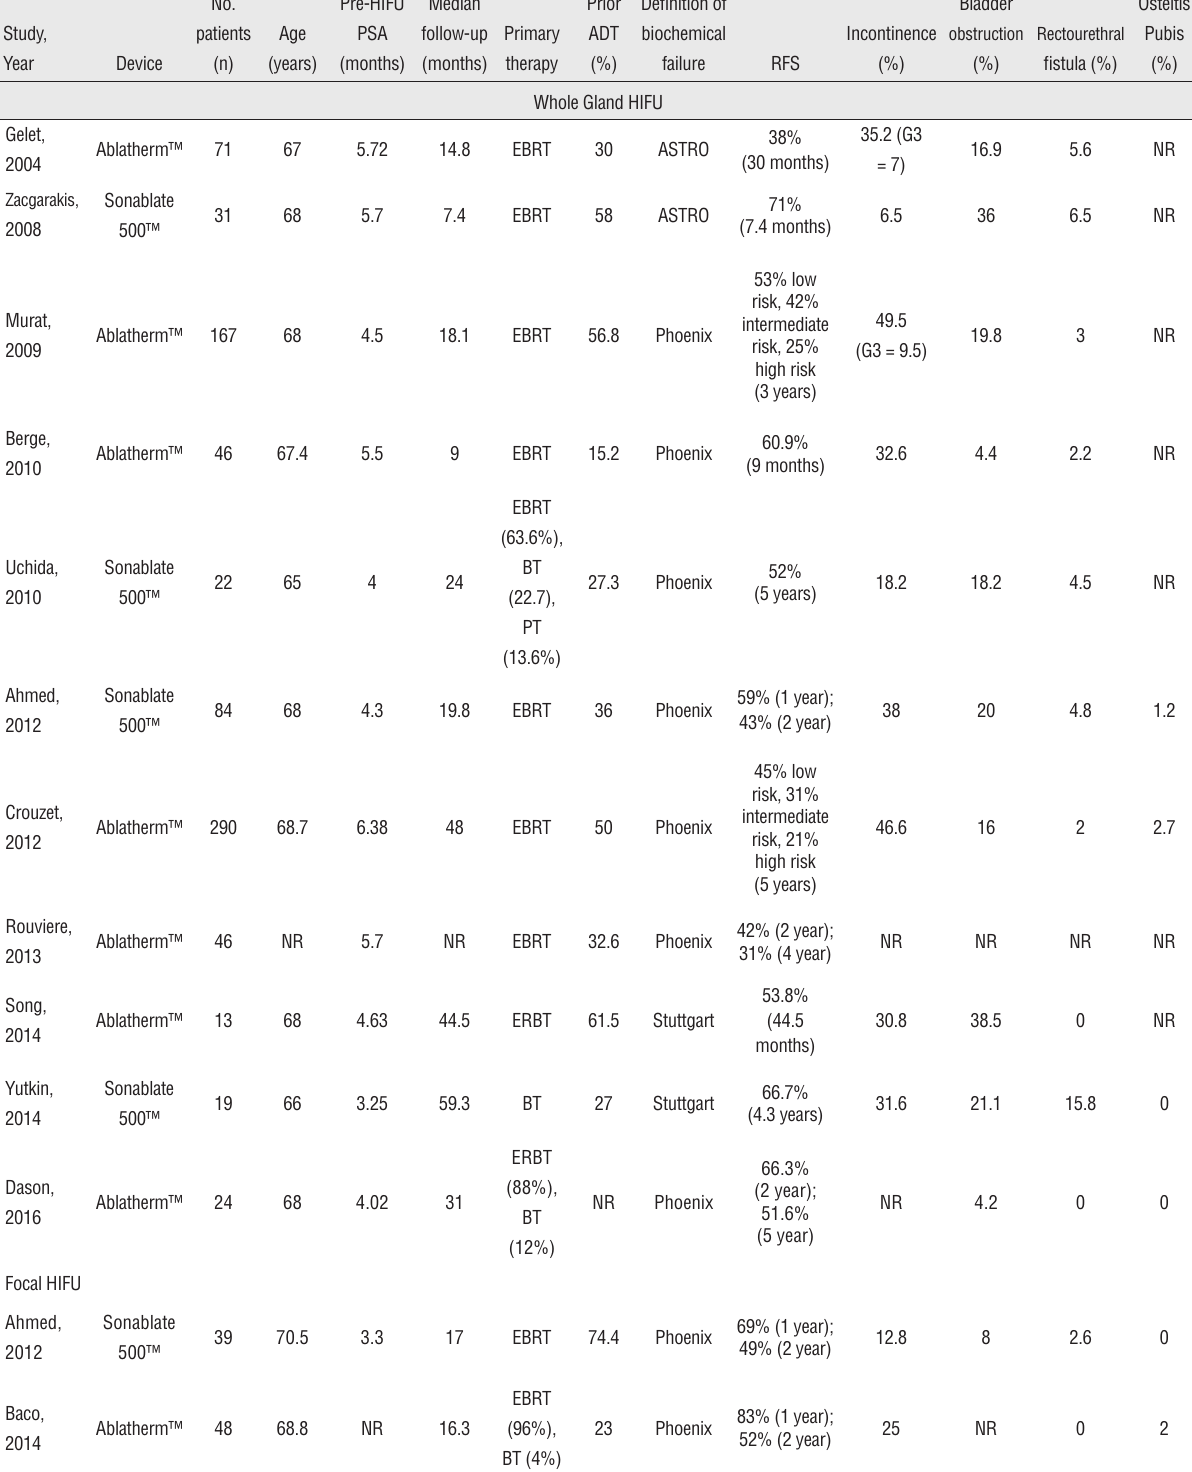
Table 2 - Review of literature for salvage HIFU (whole gland and focal) for radio-recurrent prostate cancer.